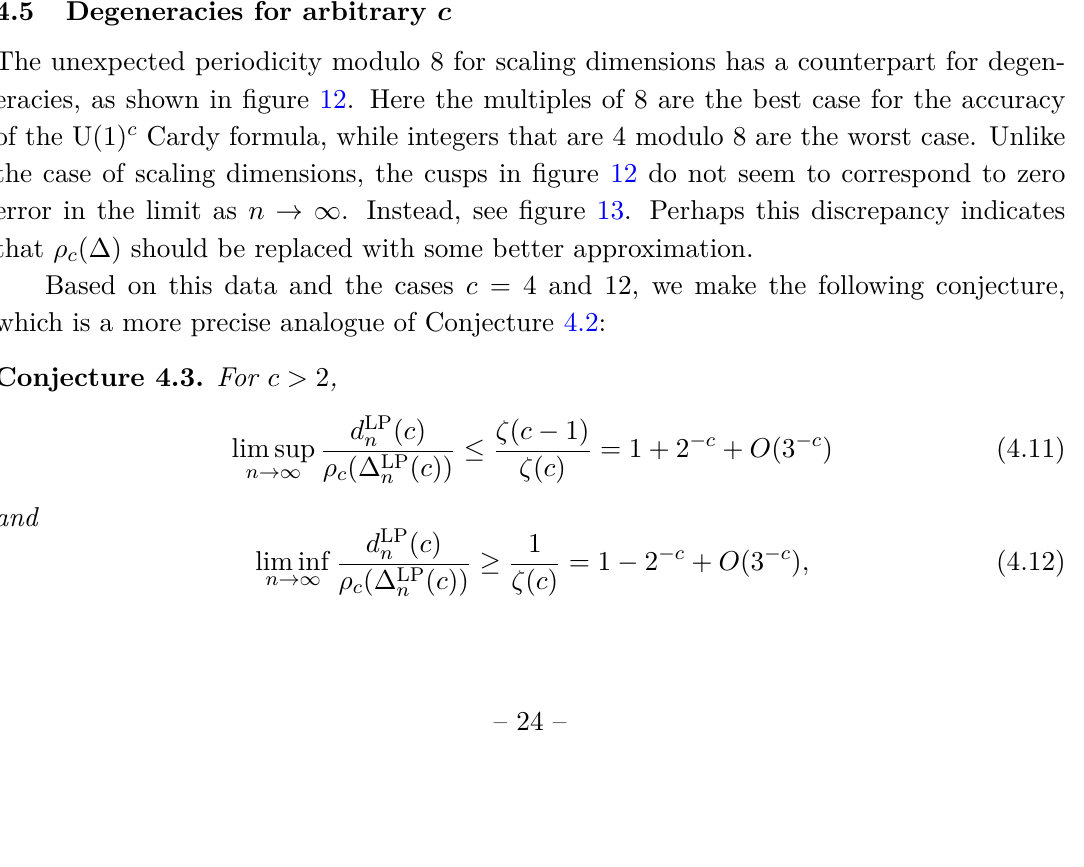
( c ) /ρ c (∆ LP ( c )) − 1 | over 2 c ≤ n ≤ 128 n n